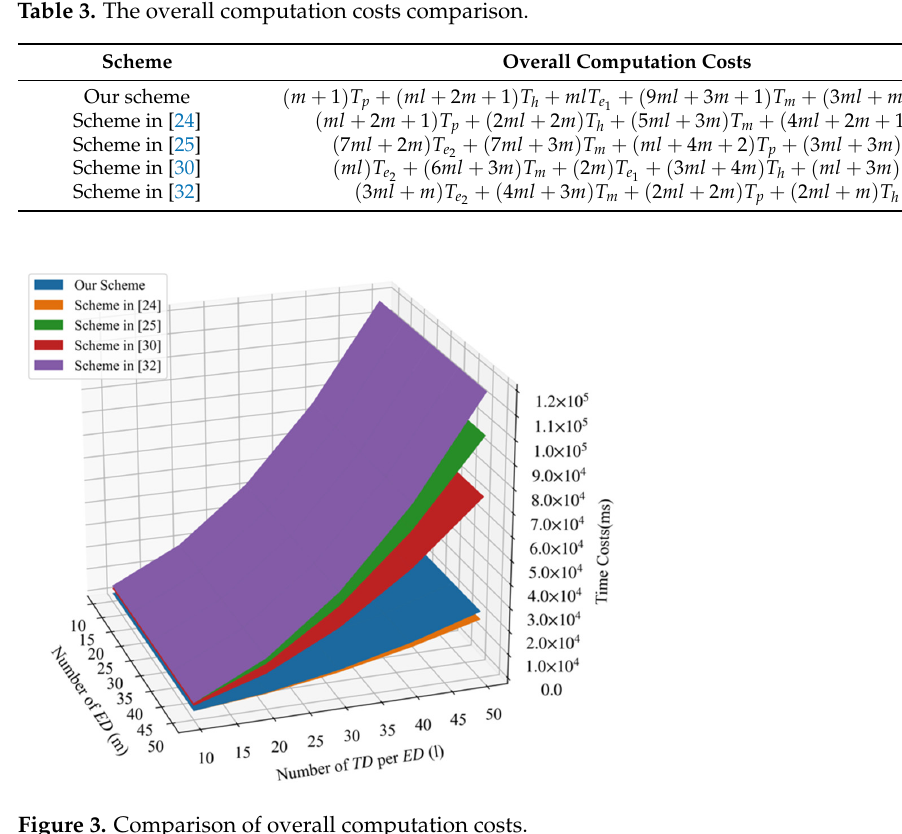
Figure 3. Comparison of overall computation costs.